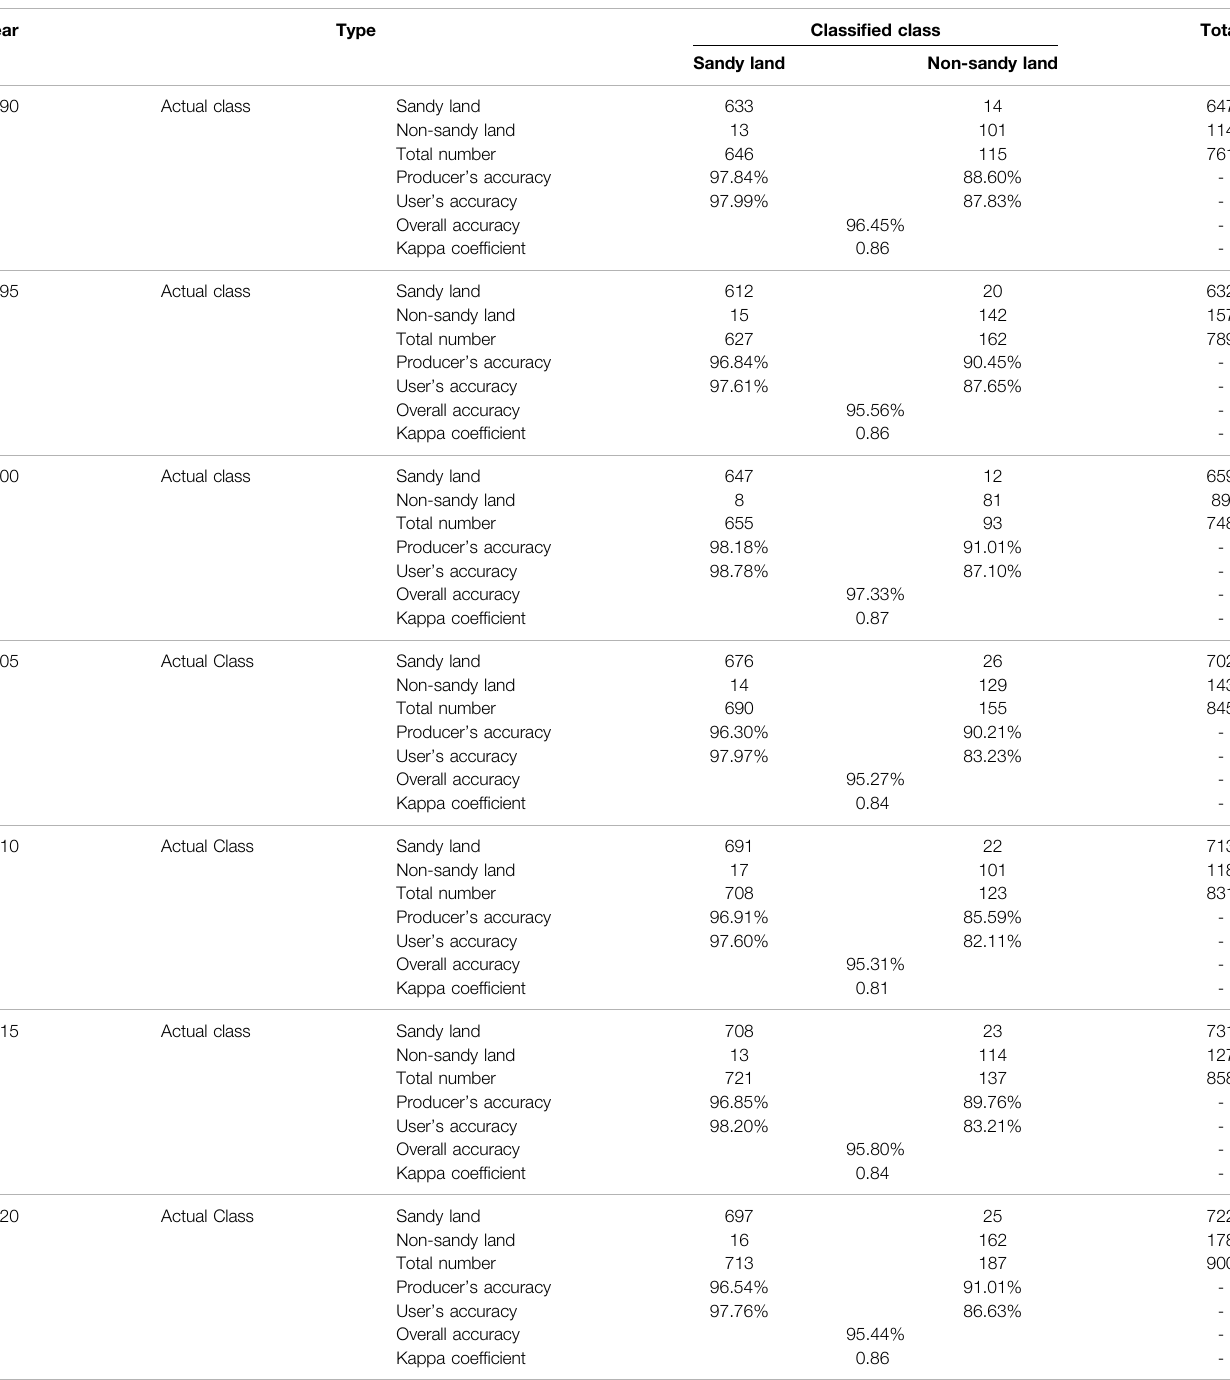
TABLE 2 | Validation of the classi fi cation results in 1990 –